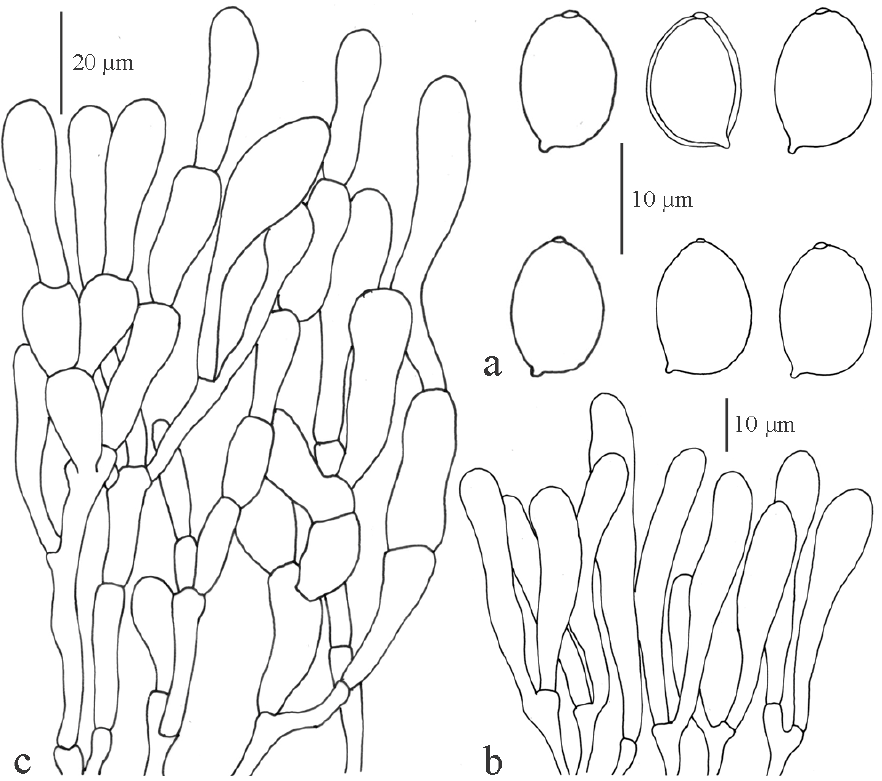
Figure 22. Microcharacters of Macrolepiota velosa (MFLU 09-0052). ( a ) basidiospores. ( b ) cheilocystidia. ( c ) pileuscovering.